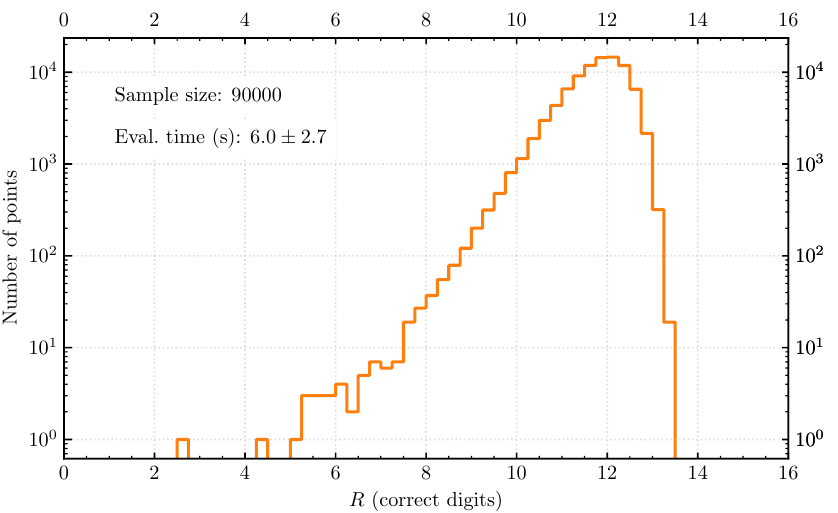
Figure 1: Logarithmic distribution of minimal correct digits (see eq. (6)) of pentagon functions evaluated on a sample of 90000 phase-space points. The average evalua- tion time of all pentagon function in double precision on a single thread is estimated on a server with Intel(R) Xeon(R) Silver 4216 CPU @ 2.10GHz . This figure is from ref. [ 33 ] licensed under CC-BY 4.0